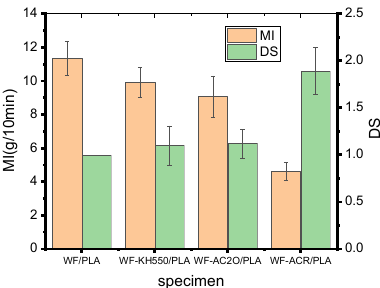
Figure 2. Melt index (MI) and relative melt die swell ratio of composite filaments.